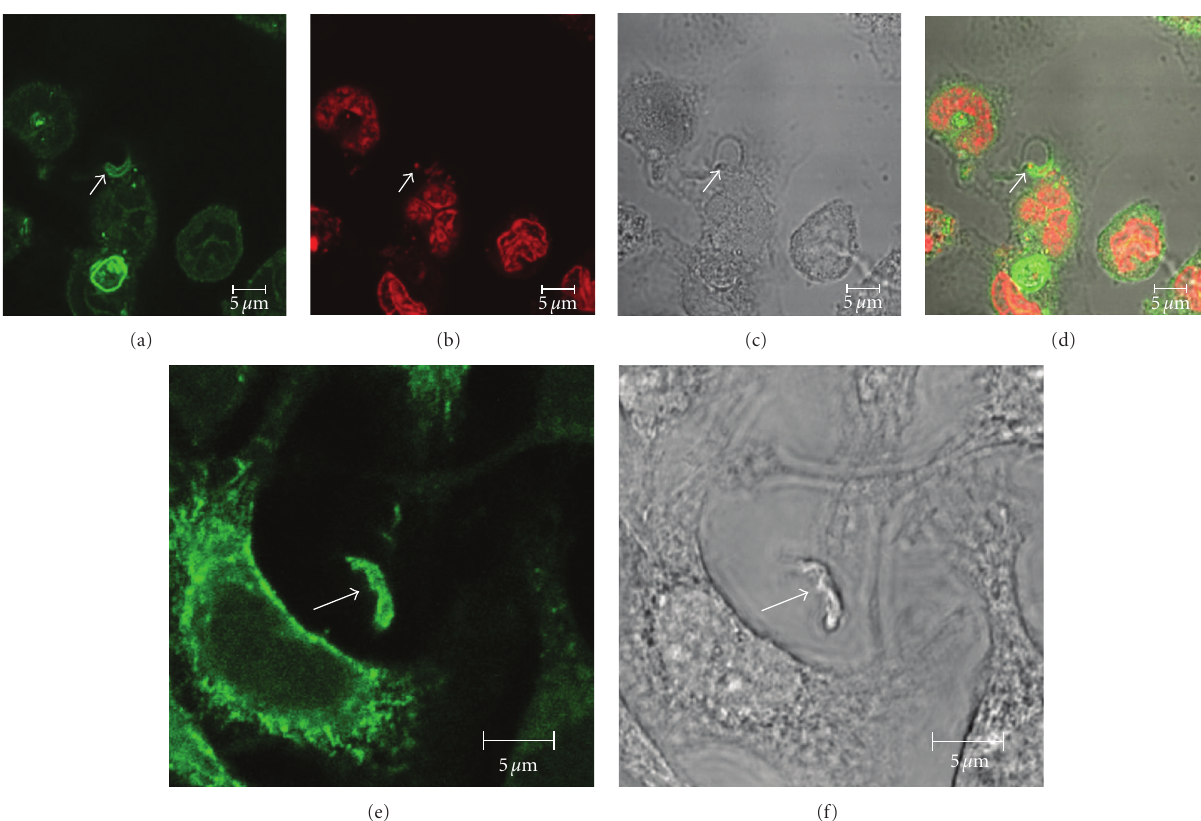
Figure 4: Imunofluorescence microscopy localization of GM1 (a–d) and flotillin 1 (e-f) during internalization of T. cruzi trypomastigotes by macrophages suggests the participation of membrane microdomins in this process. (a–d) colocalization of GM1, using cholera toxin subunit B (a) and an intracellular parasite ((c): arrow). (b) shows labeling of the nucleus and kinetoplast labeled with propidium iodide. (c) corresponds to a DIC image; (d) is a merge image. (e-f): Colocalization of flotillin1 (a), detected using a specific antibody, and trypomastigotes ((b): arrows) bars – 5 μ m (after